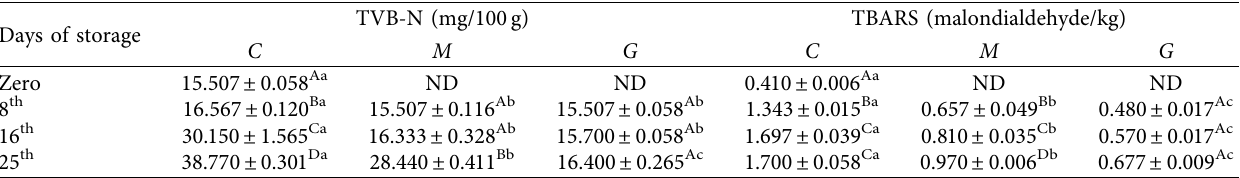
Table 2: The TVB-N and TBARS values of treated catfish fillet groups with LSSM ( M ) and LSSM-Se NPs ( G ) compared to control ( C ) during storage at refrigeration temperature ∗